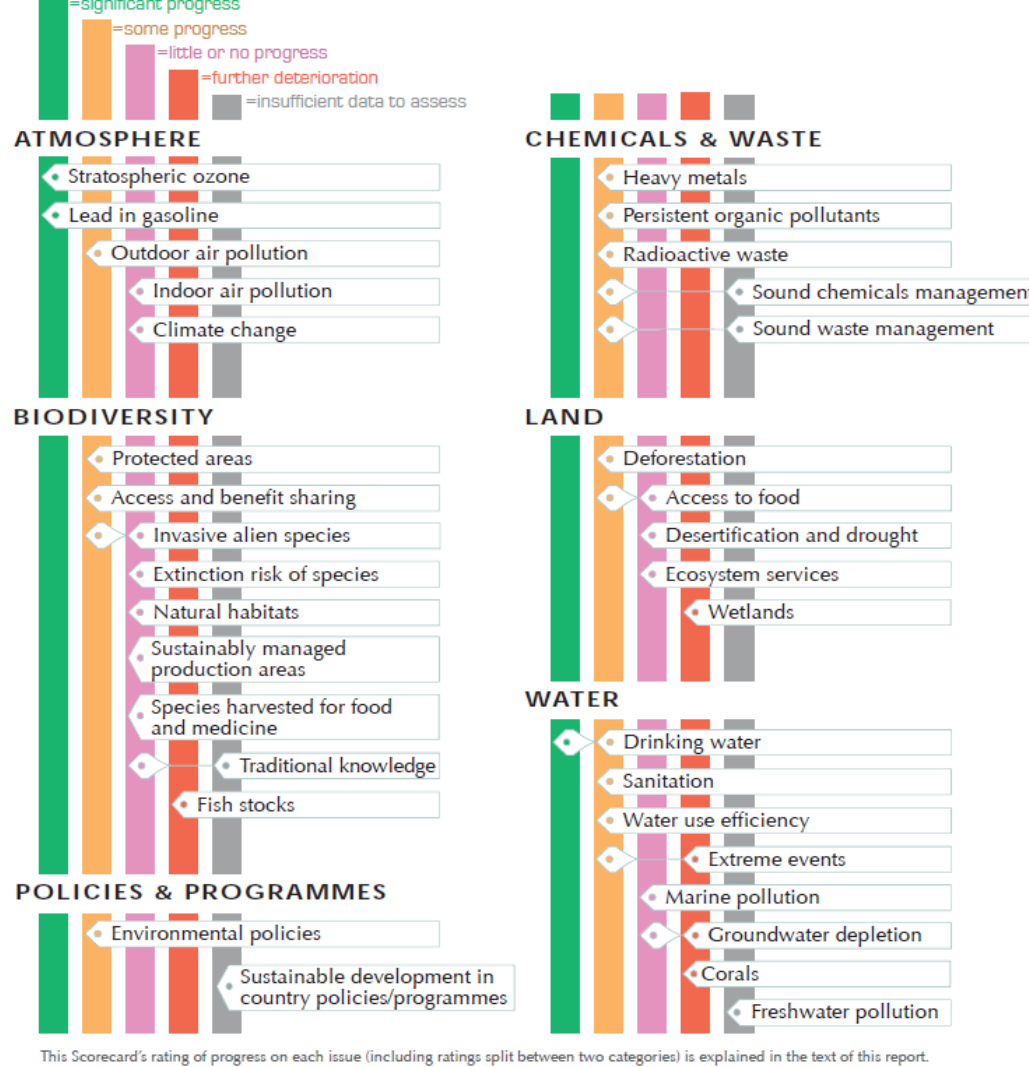
Figure 2. Environment Scorecard from GEO-5